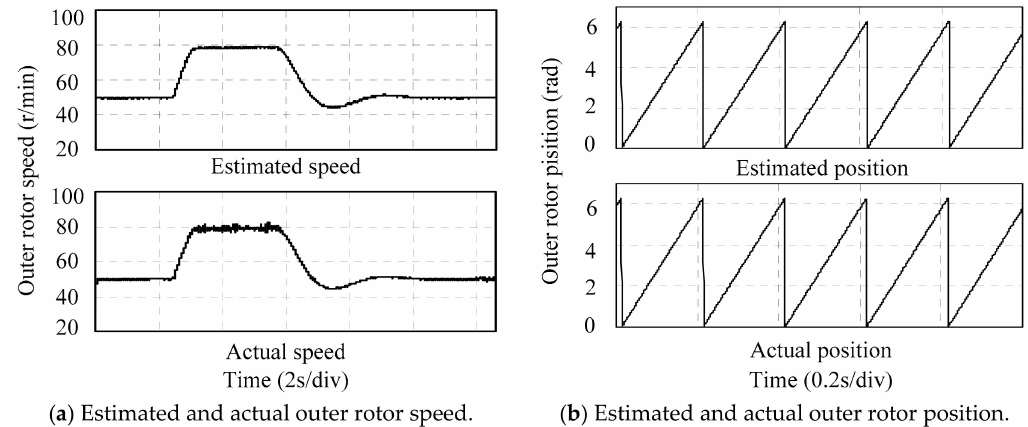
Figure 11. Experimental results of the outer rotor under the PI-based traditional MRAS